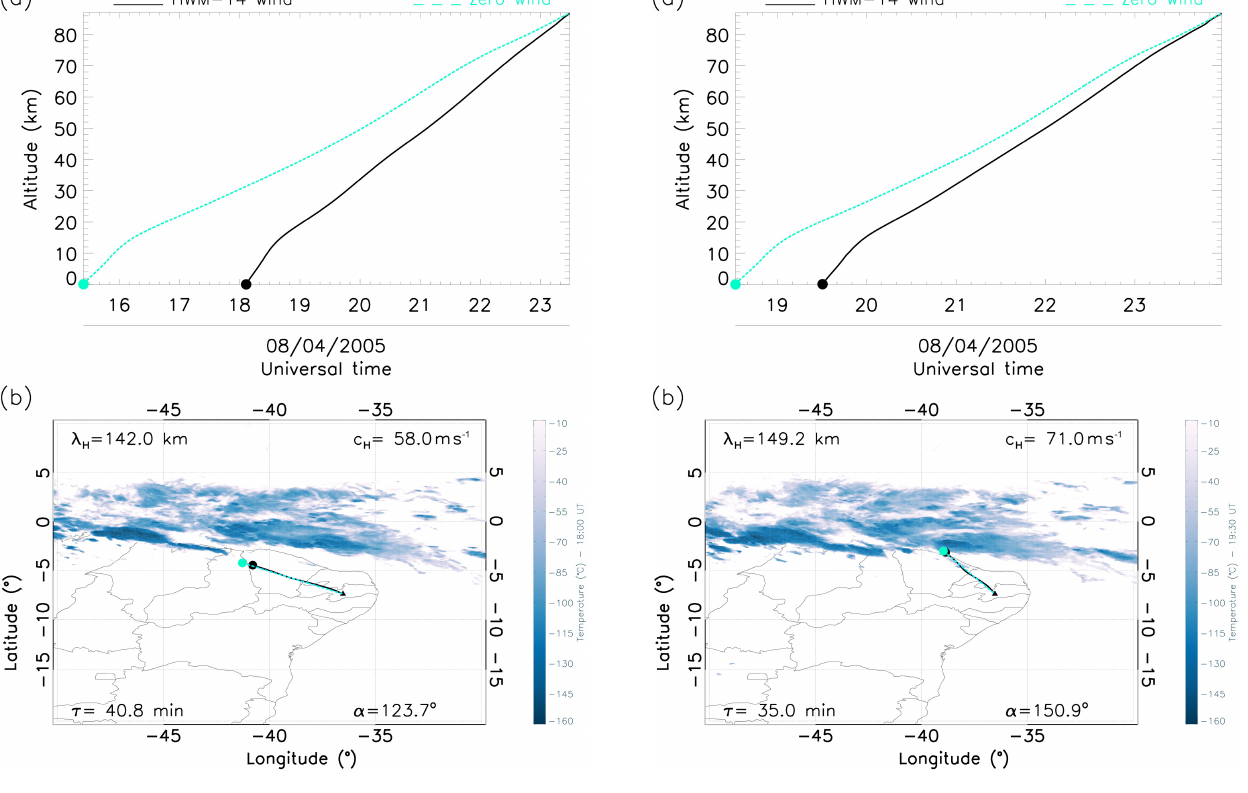
shaded region due to the effect of the critical levels (Paulino et al.,